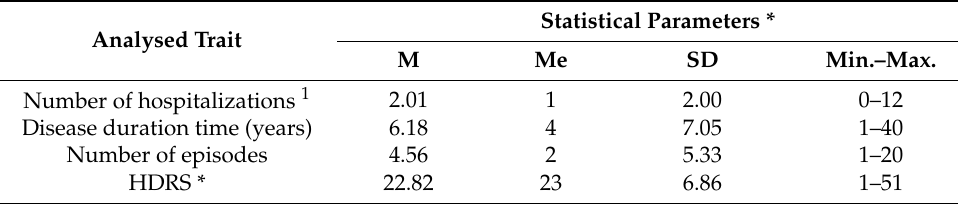
Table 1. Clinical characteristics of study